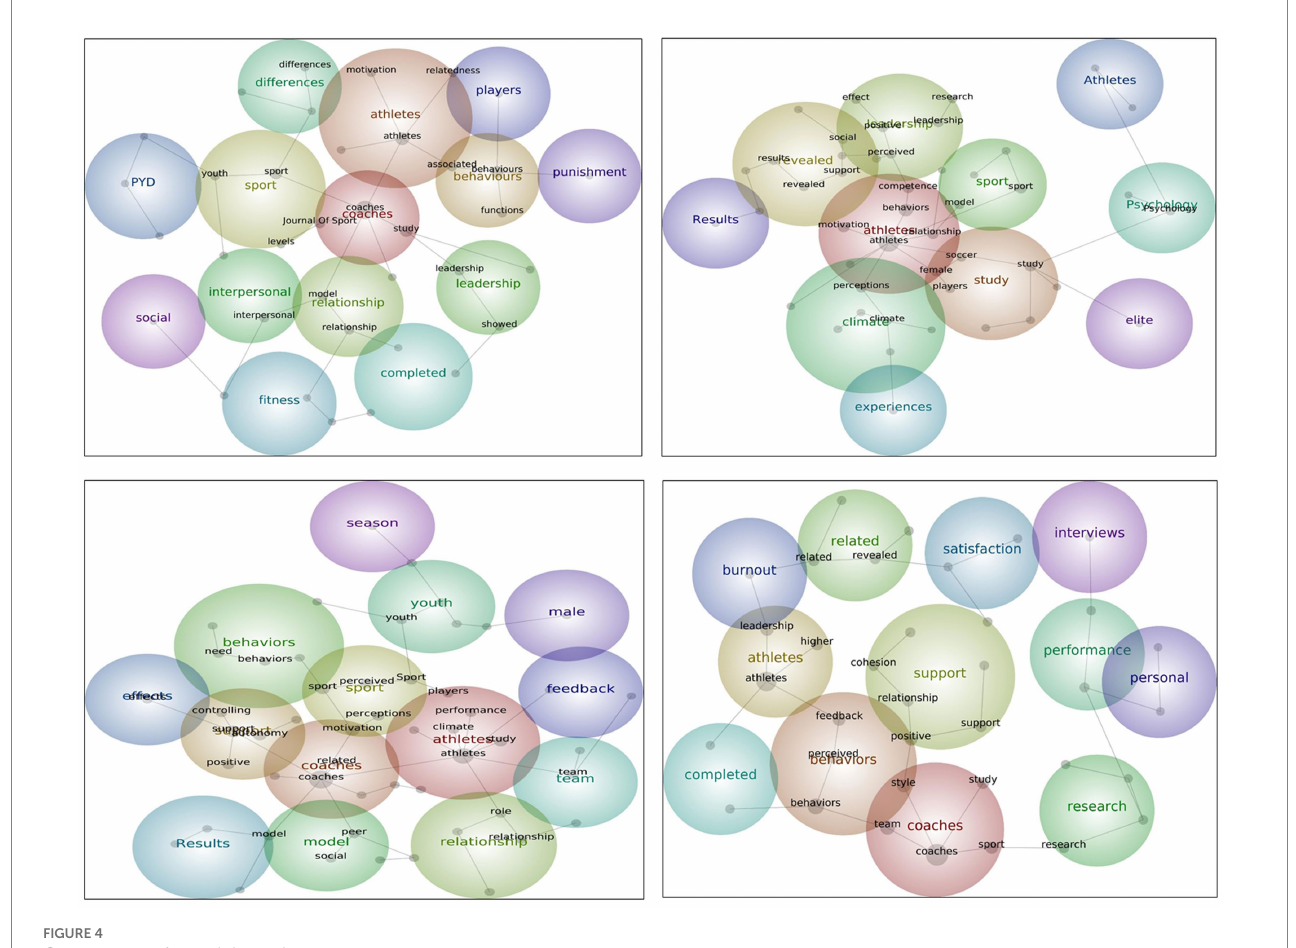
FIGURE 4 Concept maps for each